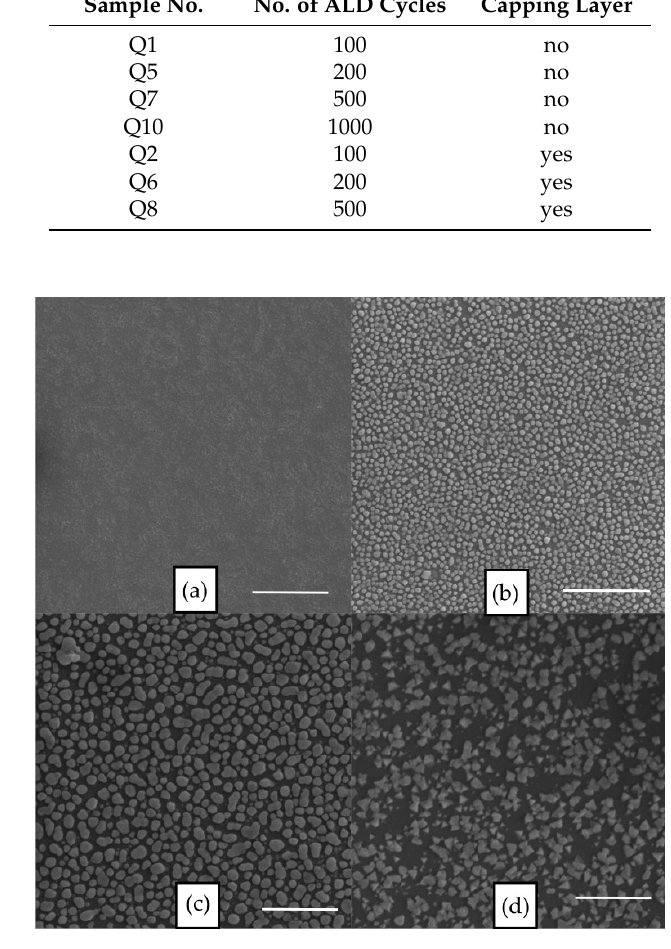
Figure 1. SEM images of CuCl deposited on soda-lime glass: ( a ) 100 c.; ( b ) 200 c.; ( c ) 500 c.; and ( d ) 1000 c. Scale bars represent 1 μ m.